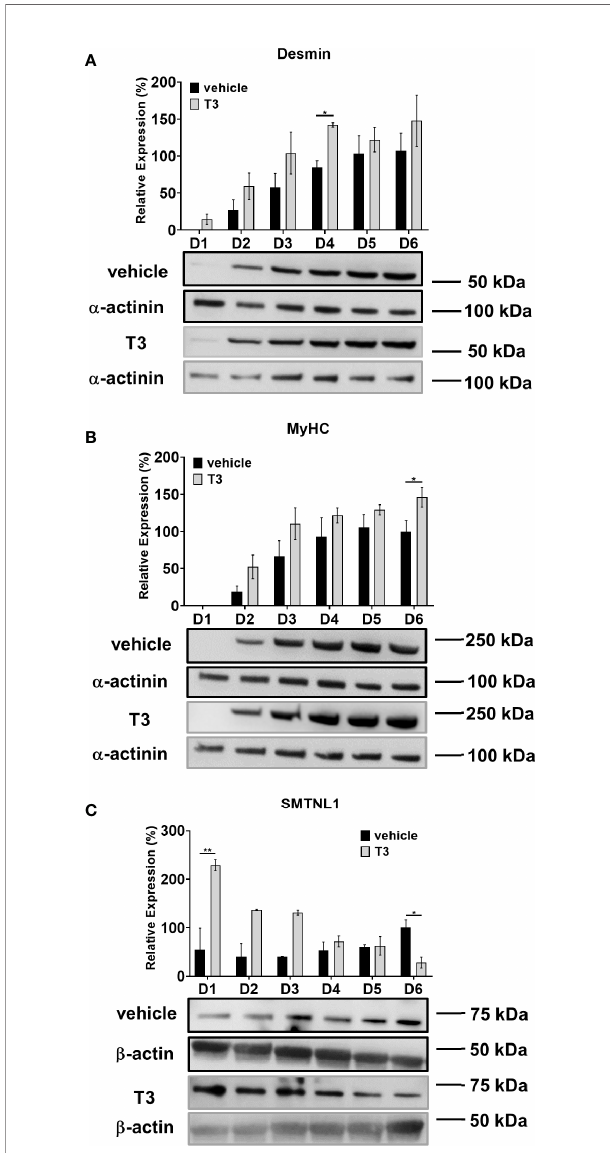
FIGURE 4 | Effect of T3 treatment on SMTNL1 expression during C2C12 myogenesis. (A – C) Myoblasts were seeded on a collagen-coated plate and differentiation was induced in the presence of 2% HS and supraphysiological (10 nM) T3. Equal amounts of 1 M HCl : EtOH solution was added to the non-treated control, indicated as ‘ vehicle ’ which contains physiological (approximately 1 nM) T3. The differentiation medium was changed daily for 6 days. Myotubes were harvested and lysates were analyzed by Western blot using anti-desmin (A) , anti-MyHC (B), and anti-SMTNL1 (C) antibodies. Values represent n=3-4, mean +/- SEM. Data were normalized to the D6 vehicle control. Groups were compared using Two-way ANOVA and Tukey ’ s post hoc test, p < 0.05 (*), p < 0.01